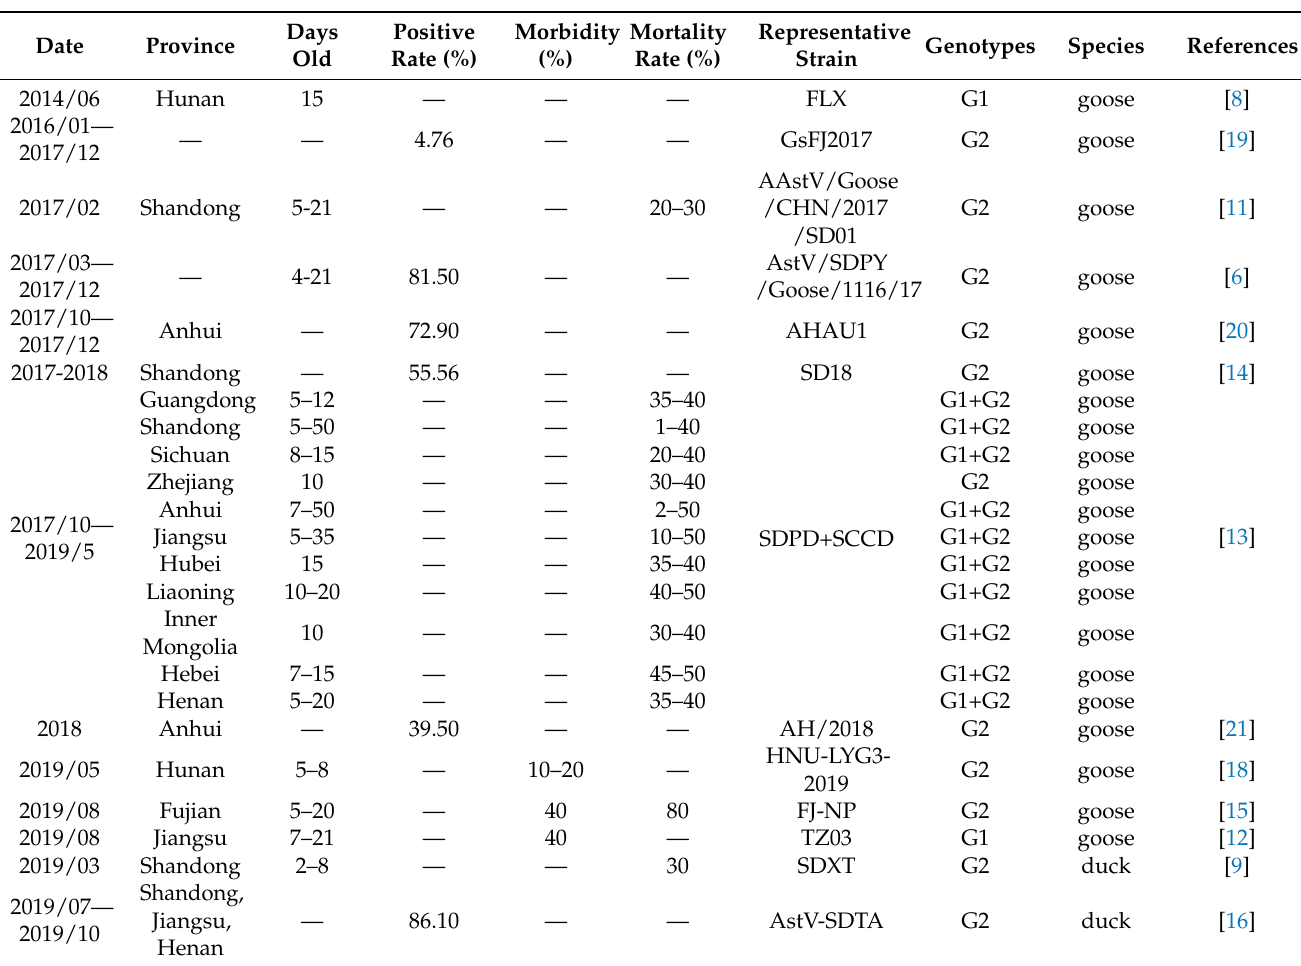
Table 1. Summary of different epidemiology parameters from the different outbreaks of GoAstV between 2014 and 2019 in